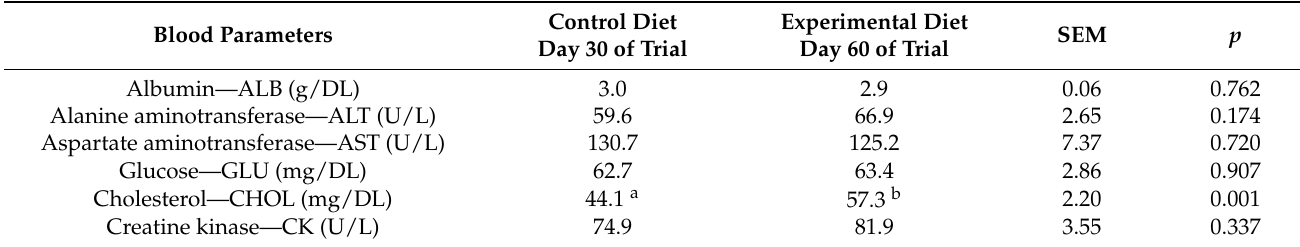
Table 4. Effect of dietary supplementation on ovine blood